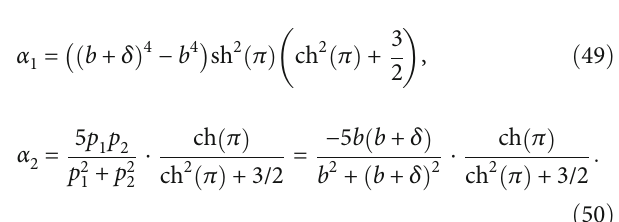
Figure 2: Initial pro fi le u